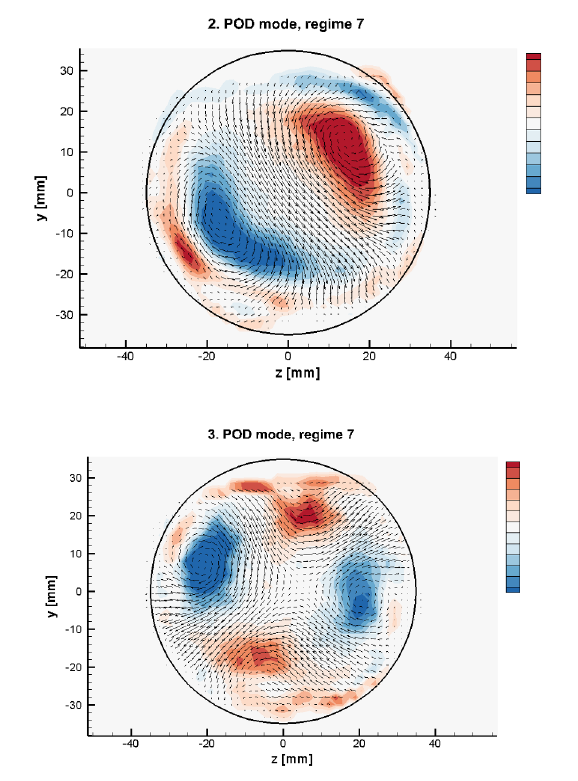
Fig. 7a, b. POD modes for regime No. 7, cross-sectional plane, 2 nd (a) and 3 rd (b), vorticity